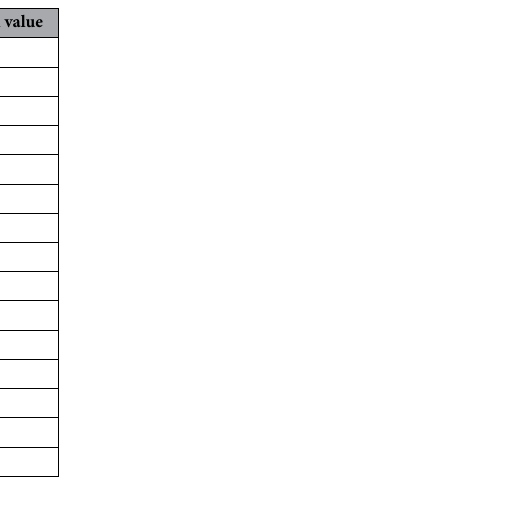
Table 1. EDEM simulation parameter